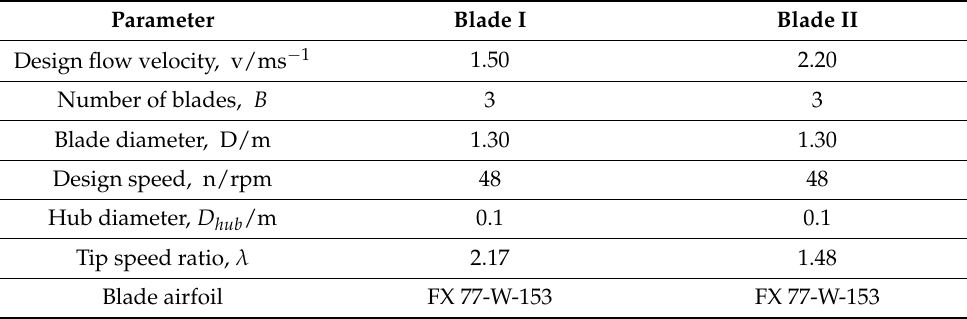
Table 2. The design parameters of two blades.